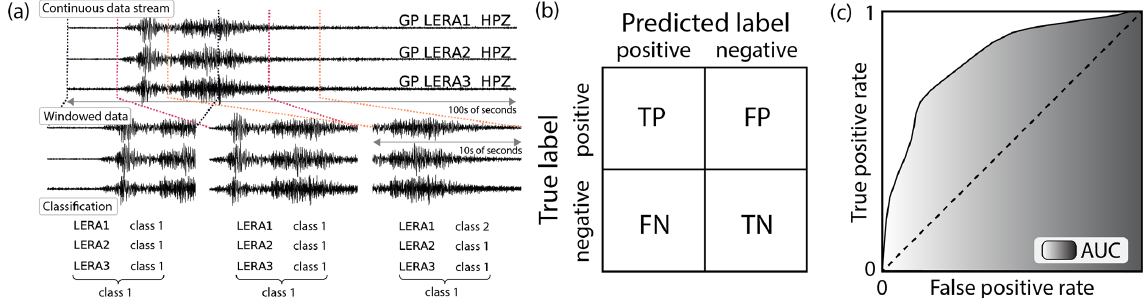
Figure 4. (a) One-step classification scheme with continuous data stream, windowed data, classification per station, and label for window; (b) confusion matrix for a two-class problem (positive, negative), with true labels as rows and predicted labels as columns. True posi- tives (TPs) and true negatives (TNs) on the diagonal, and false negatives (FNs) and false positives (FPs) on the off-diagonal elements. (c) ROC curve with true-positive rate (TPR) on the y axis and false-positive rate (FPR) on the x axis. Shaded area (AUC) measures model